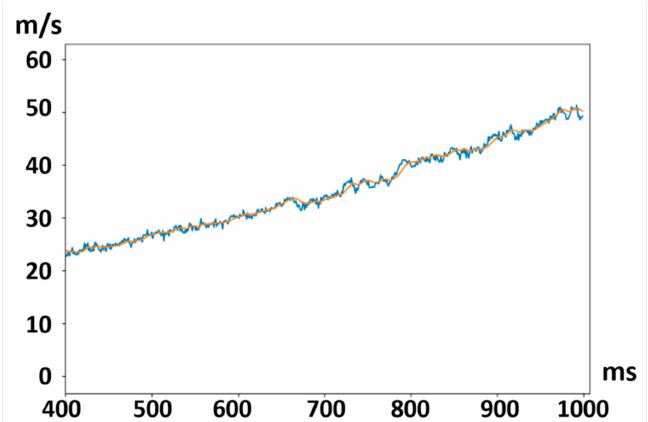
Figure 9. Output response with EKF of level 1.